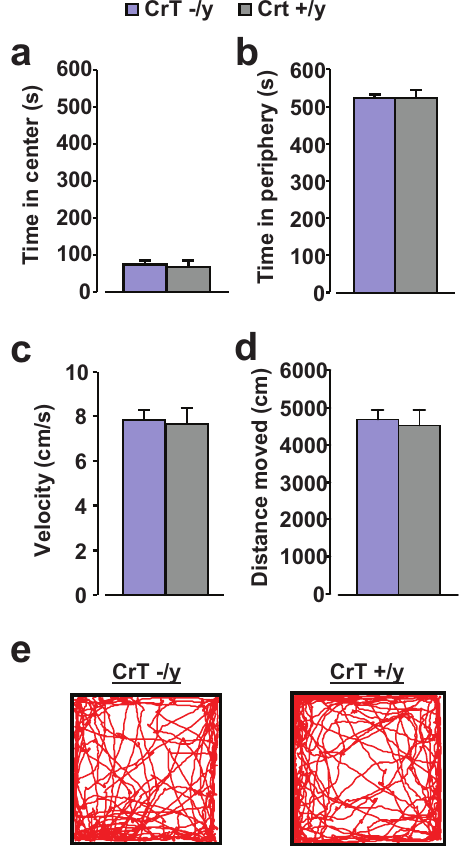
Figure 3. Normal behavior of CrT mutant mice in the open field arena. ( a , b ) CrT –/y (n = 9) and CrT +/y mice (n = 9) spent a comparable amount of time in the center (CrT –/y : 75.16 ± 10.82 s, CrT +/y : 67.60 ± 18.11 s; a ) and in the peripheral region (CrT –/y : 524.41 ± 10.87 s, CrT +/y : 526.52 ± 18.45 s; b ) of the open field arena. A Two-Way ANOVA analysis shows no significant effect of genotype for both comparisons (p = 0.725 and p = 0.922, respectively). ( c ) Walking speed of animals during the exploration of open field arena. We found no significant difference (CrT –/y : 7.85 ± 0.43 cm/s, CrT +/y : 7.65 ± 0.71 cm/s; t test, p = 0.807). ( d ) The total distance moved in the open field arena did not differ between CrT mutants (4706.34 ± 258.75 cm) and WT animals (4535.28 ± 427.11 cm; t test, p = 0.736). ( e ) Representative examples of movement path during the open field session for a CrT –/y (left) and a CrT +/y mouse (right). Error bars,